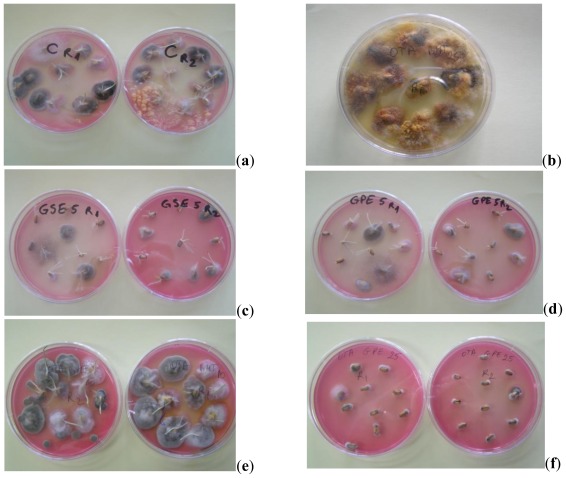
Images of the wheat grain contamination with different treatments applied (a) high level of contamination in control sample; (b) high level of contamination with Eurotium amstelodami (teleomorph of Aspergillus vitis) on DG 18 medium; (c) sample treated with 500 ppm GSE after 7 days; (d) sample treated with 500 ppm GPE after 7 days; (e) high level of Cladosporium and Alternaria in sample treated with 1000 ppm BHT after 14 days; (f) sample treated with 2500 ppm BHT after 21 days.